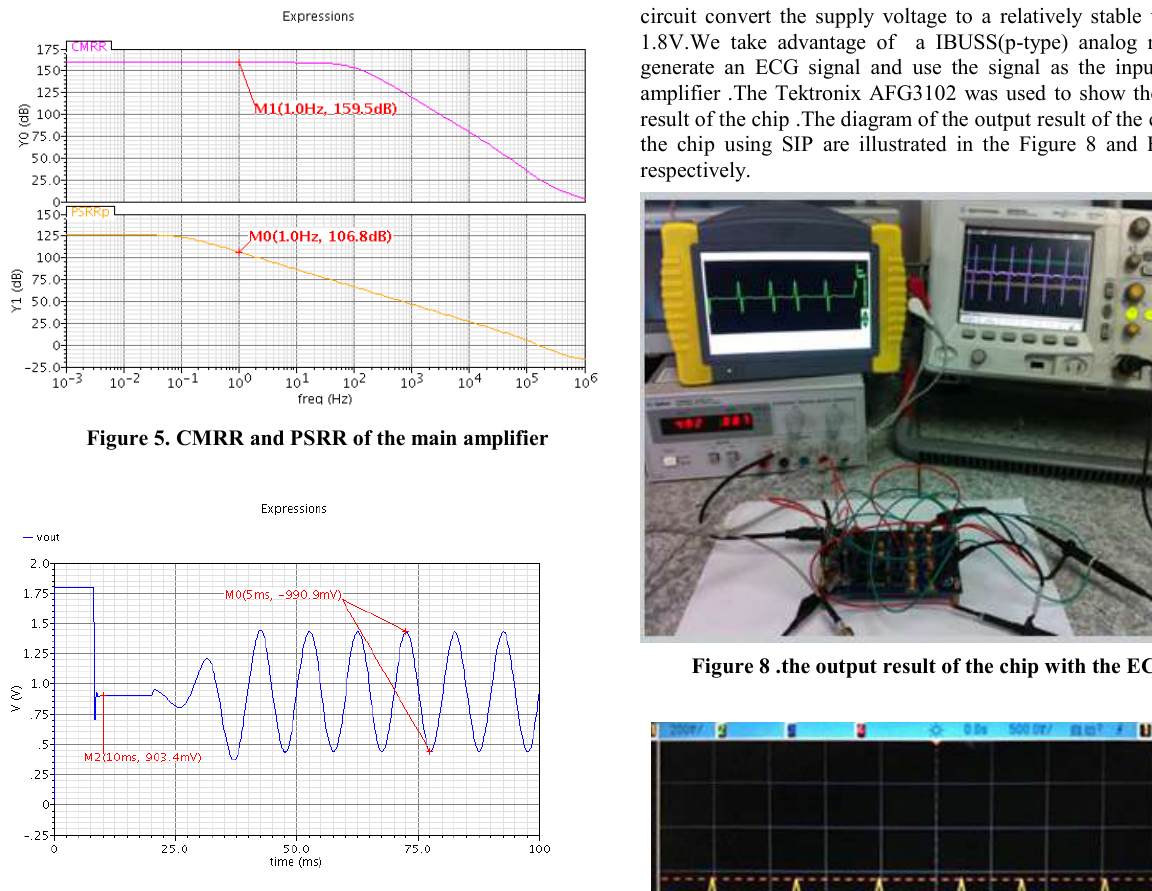
Figure 6.Transient response